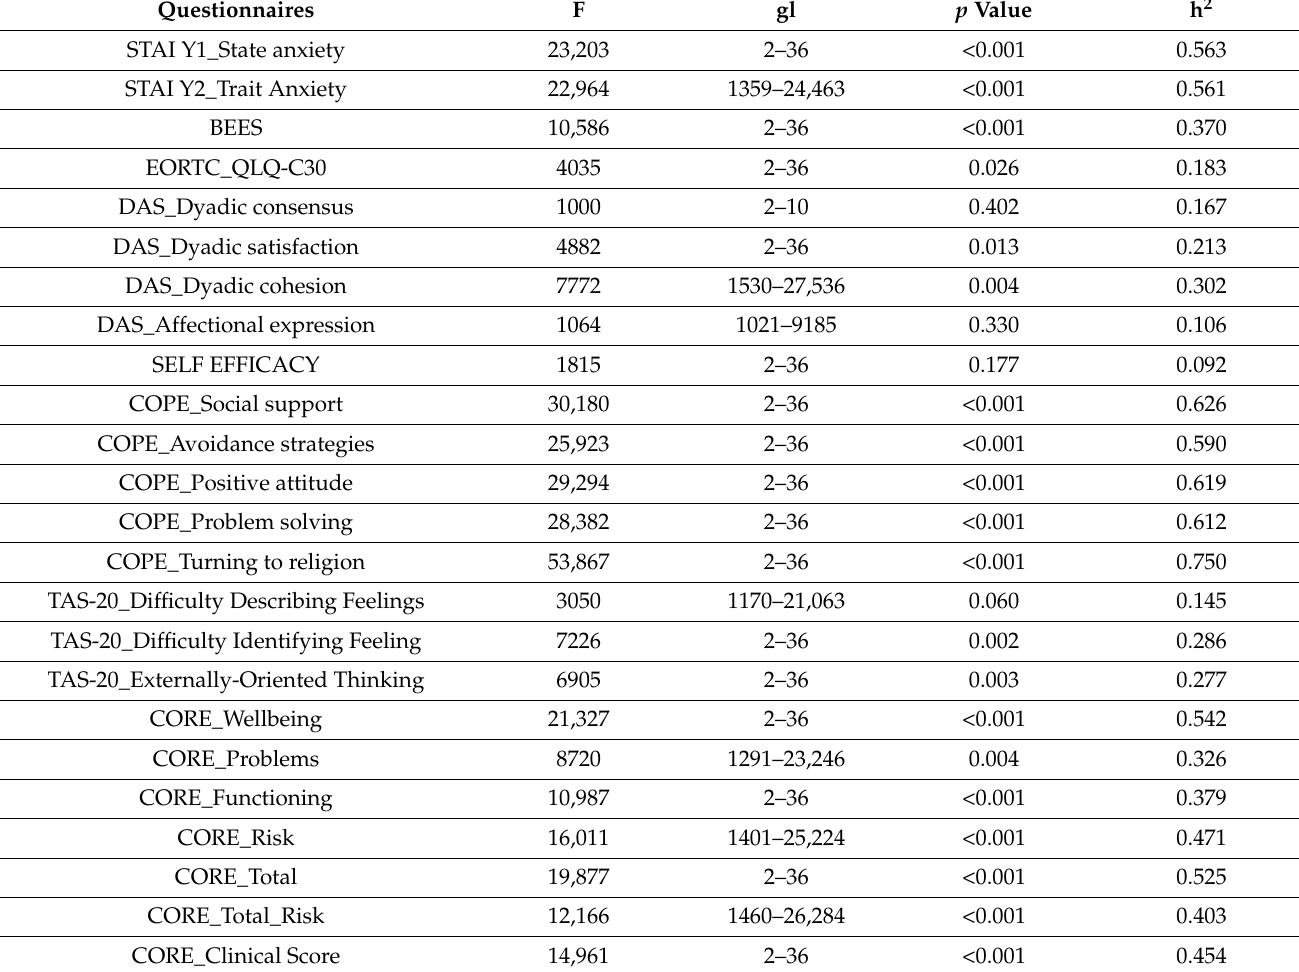
Table 3. Repeated-Measures ANOVA for T0, T1, T2: sample of 19